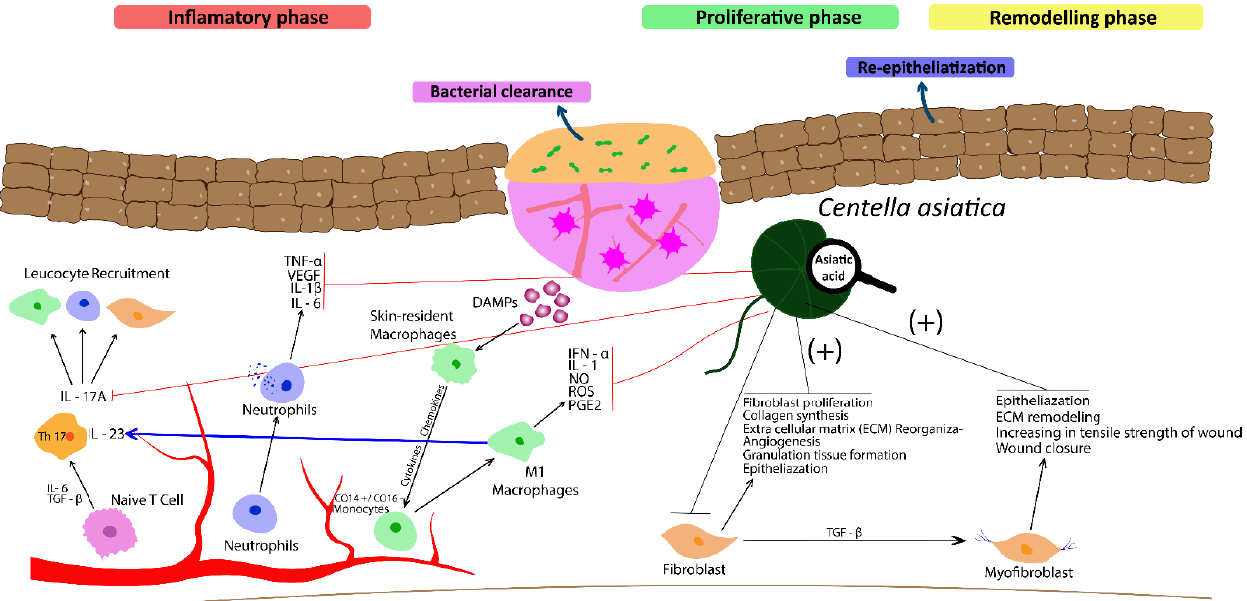
Figure 2. Centella asiatica extract (CAE) and its bioactive constituent, asiatic acid (Aa) display a decrease in the wound area and faster healing by increasing collagen synthesis, and cellular prolifera- tion, fibroblast division and re-epithelialization during proliferative and remodeling phases of wound healing. CAE and Aa also act in the inflammatory phase by inhibiting recruitment of im- mune defense cells, reducing synthesis of pro-inflammatory cytokines (TNF- α, IL -6, and and IL- 1β) and growth factors (TGF- β, PDGF and VEGF). Moreover, Aa inhibits the increase of serum levels of IL-17/IL-23. This figure was created with Adobe Illustrator.